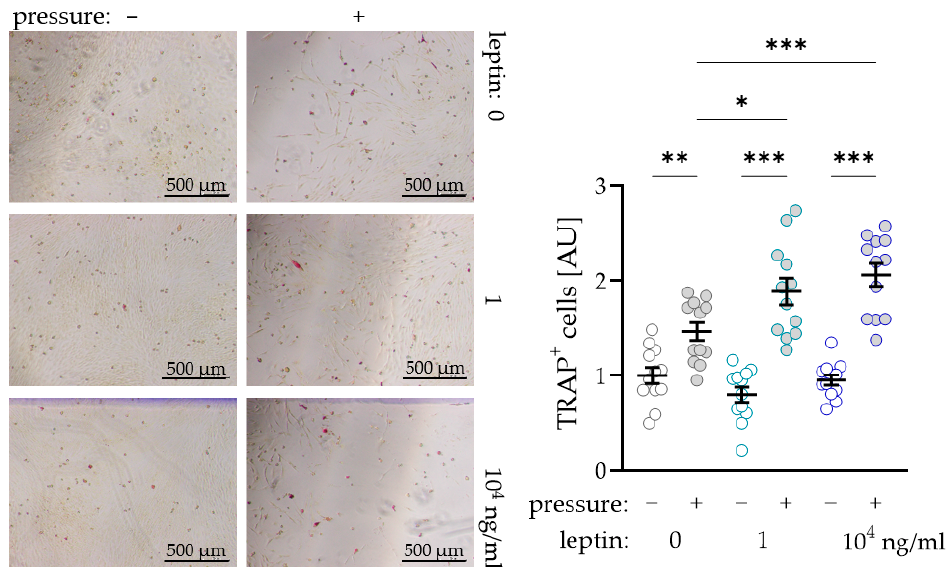
Figure 4. Impact of leptin in combination with compressive strain on the differentiation of osteoclast precursor cells to TRAP + (tartrate-resistant acid phosphatase) osteoclasts via PDLF interaction; n ≥ 12; Statistics: ordinary ANOVA with Holm–Sidak´s multiple comparison tests; * p < 0.05, ** p < 0.01, *** p < 0.001.